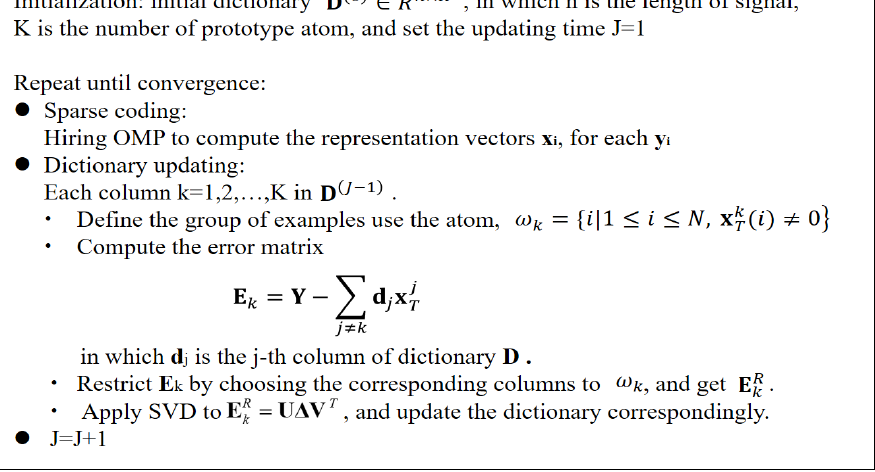
Figure 3. The pseudocode of K-SVD algorithm.